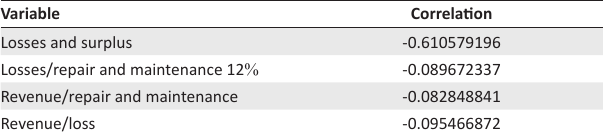
TABLE 8: Pearson’s